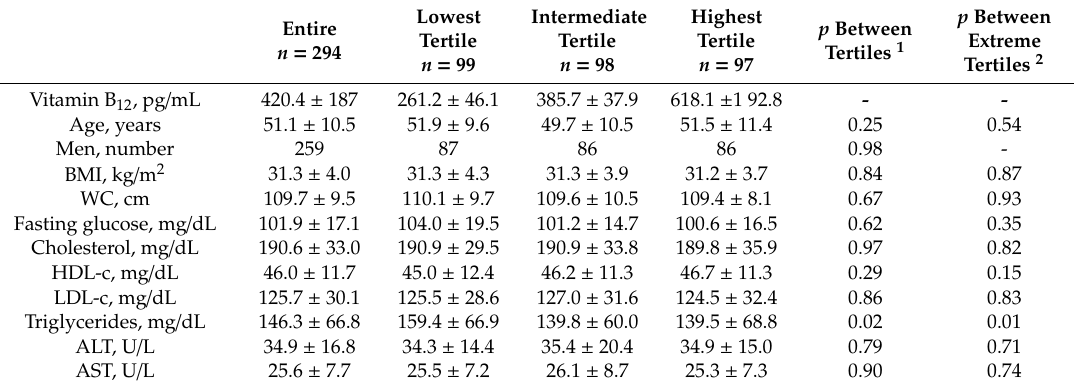
p Between p Between Extreme Tertiles 1